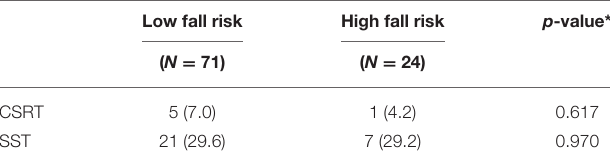
Data are mean (SD). IIV: intra-individual